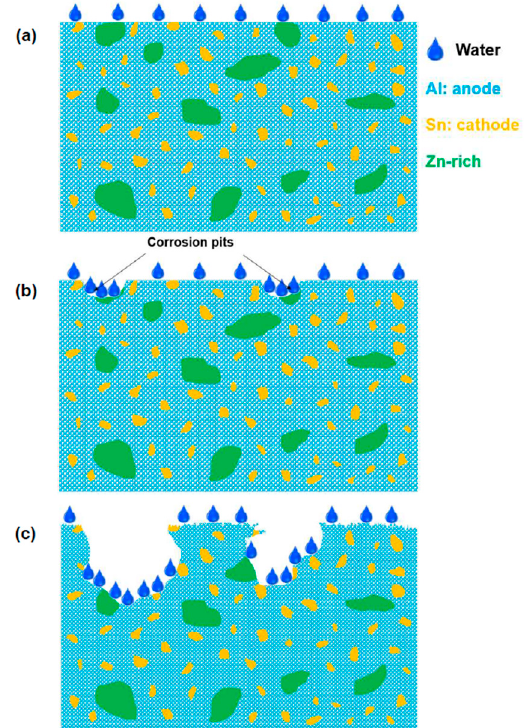
Figure 14. XPS spectra of ( a ) Al, ( b ) Sn, and ( c ) Zn for Al-30wt %Sn-10wt %Zn powders processed by HPT for N = 20 and immersed in water at room temperature for 4 h.